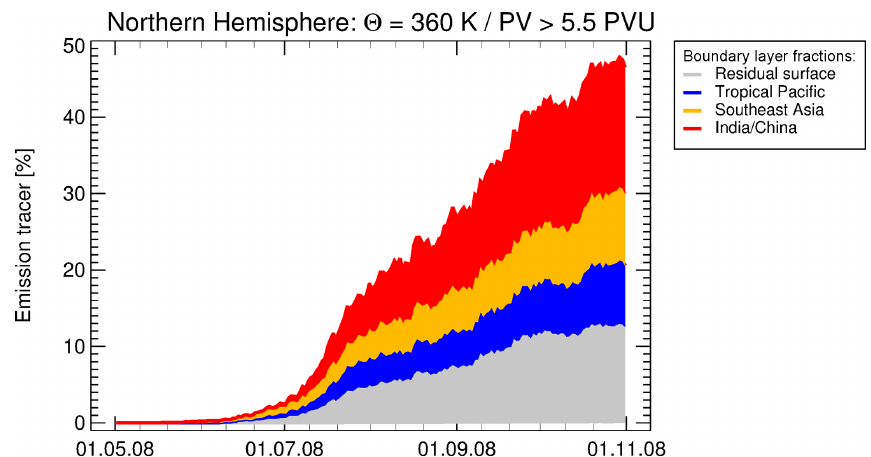
Figure A2. Contribution of different emission tracers from India/China, Southeast Asia, the tropical Pacific Ocean, and residual surface to the northern lower stratosphere at 360K from May to October